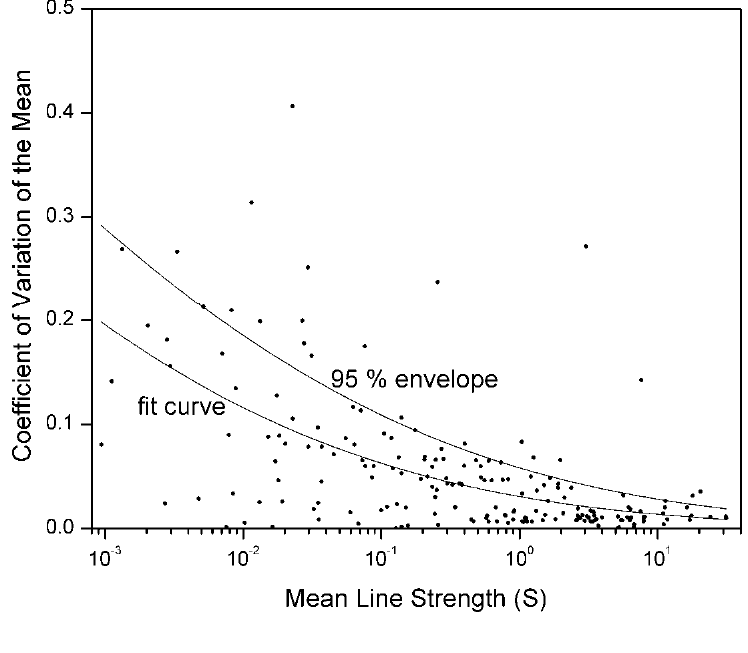
Figure 2. The (cid:1829) (cid:3023)(cid:3041) data points are the same as Figure 1, to which two curves have been added. Seven outliers, three of which are off the scale, were given small weights. Because only two data sources were used, the (cid:1829) (cid:3023)(cid:3041) for each transition is given by Equation (4a). For the lower curve, parameters β [LS] and (cid:1876)̅ [LS] in Equation (6) were evaluated by a LS fit, (cid:2869)/(cid:2870) [ p ] was then adjusted in and β [LS] was found to be 4.2 (“slope”). Keeping the same β , (cid:1876)̅ (cid:2869)/(cid:2870) Equation (7) until 95% of the points (excluding outliers) lie under the upper curve, for which (cid:1876)̅ [p] = 5.1 × 10 − 5 (“intercept”). Compare to Figure (cid:2869)/(cid:2870)